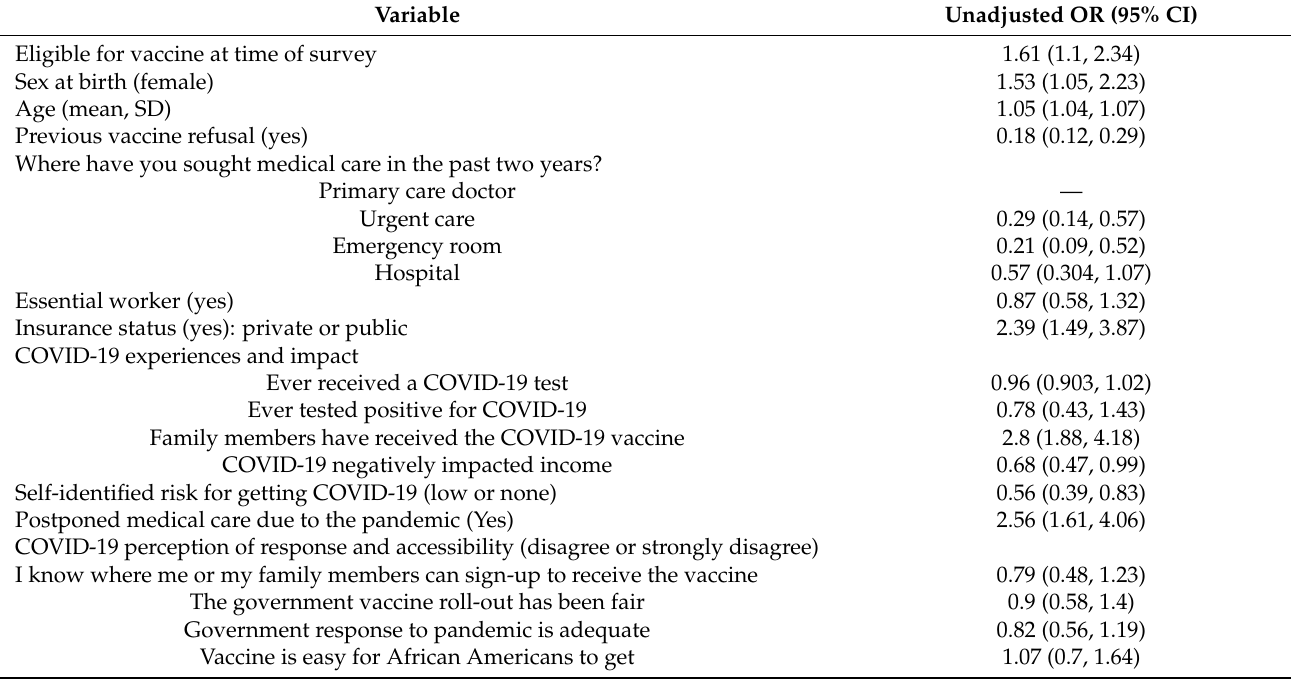
Table 2. Results of Bivariate Analysis of Intent to Receive